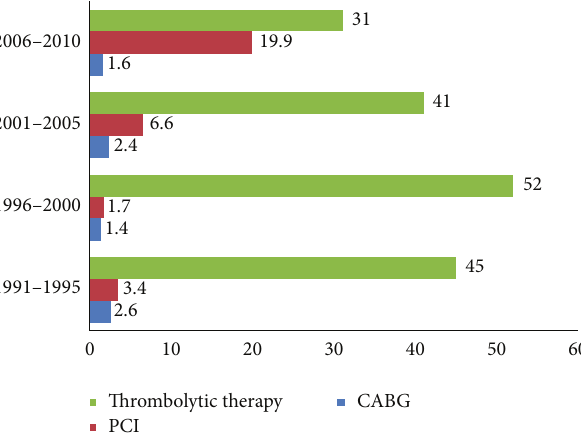
Figure 2: Trends in coronary reperfusion and revascularization procedures (%) over 2